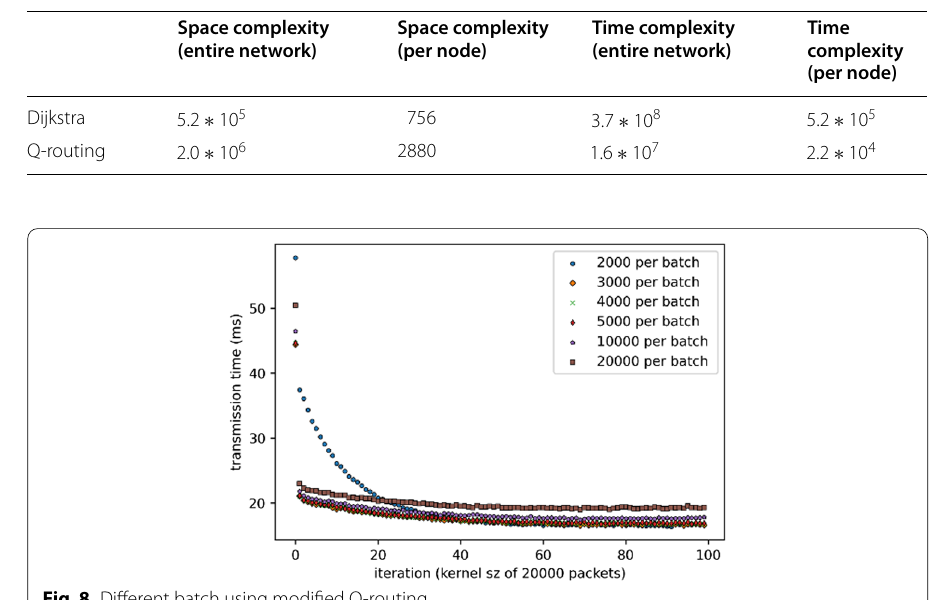
Fig. 8 Different batch using modified